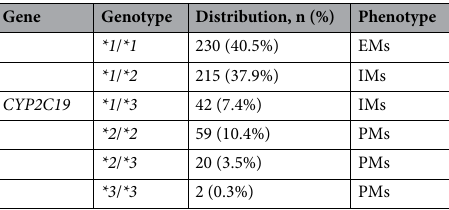
Table 1. Genotypic and allelic frequencies and phenotypes of patients. EMs, extensive metabolizers; IMs, intermediate metabolizers; PMs, poor metabolizers.